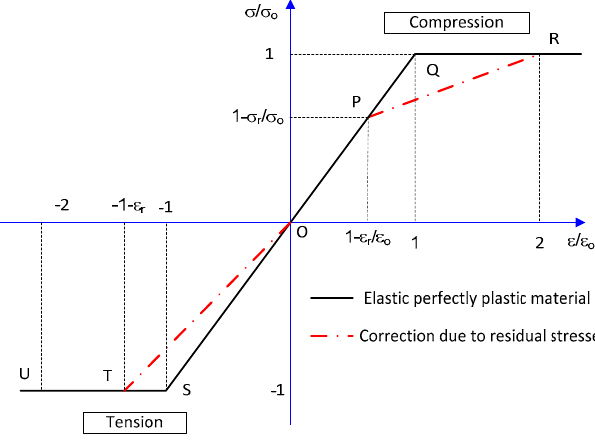
Figure 16. Average stress-strain curve for an unstiffened plate with and without residual stresses.